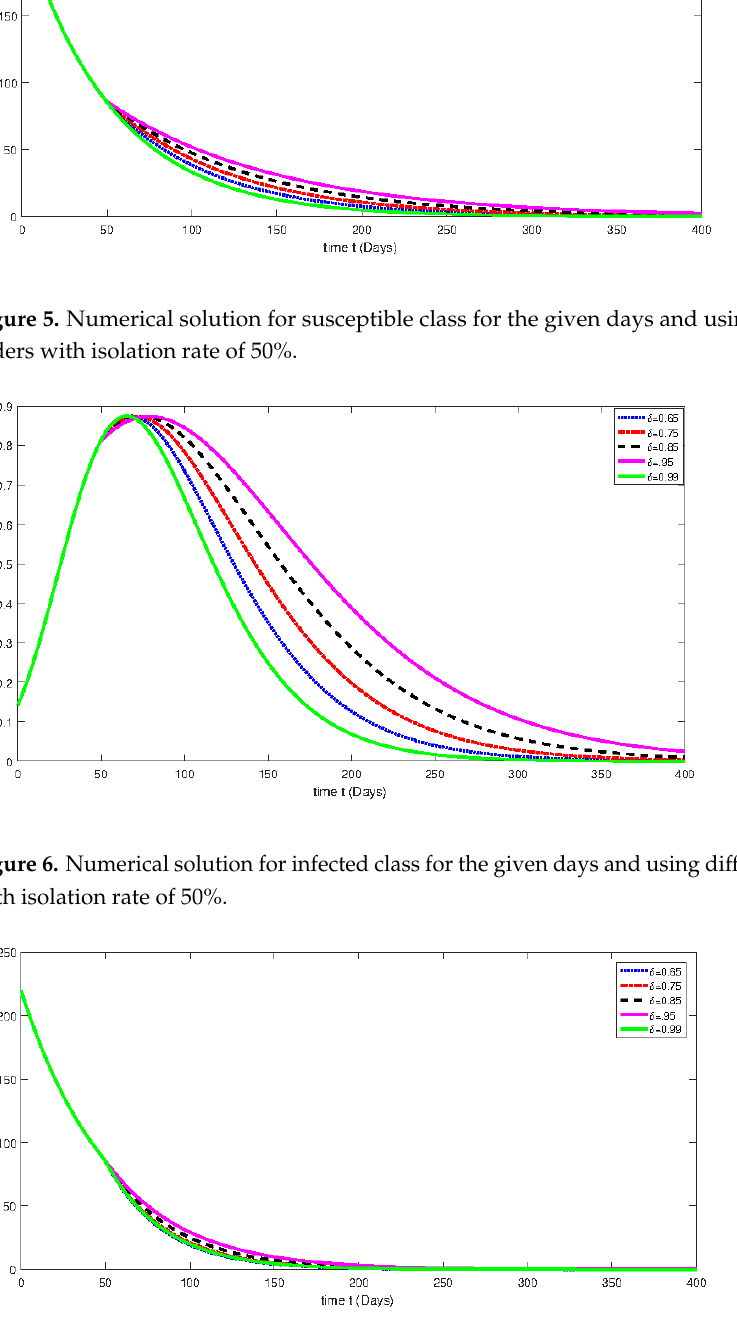
Figure 7. Numerical solution for susceptible class for the given days and using different fractional orders with isolation rate of